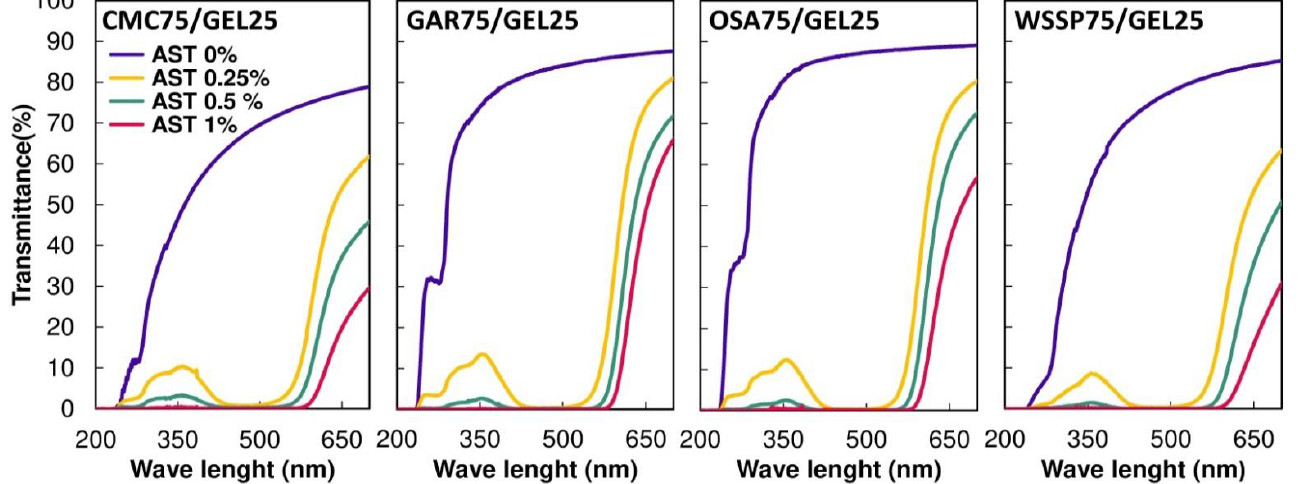
Figure 2. Effect of the increasing concentration of AstaSana astaxanthin (AST) on the light transmis- sion of the films obtained from the 75/25 blends of polysaccharides (carboxymethyl cellulose (CMC), gum Arabic (GAR), octenyl succinic anhydride starch (OSA), and water-soluble soy polysaccharides (WSSP)) and gelatin (GEL).